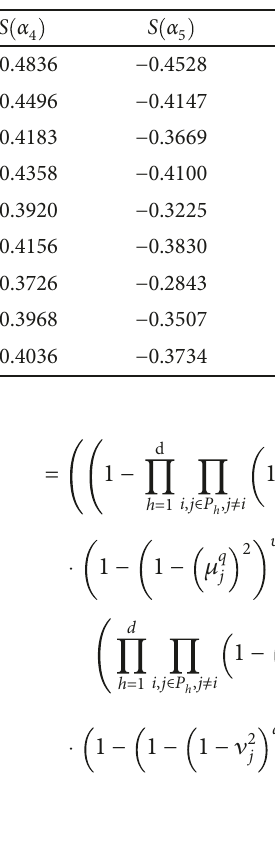
Table 10: Results of di ff erent p and q without considering interaction with one